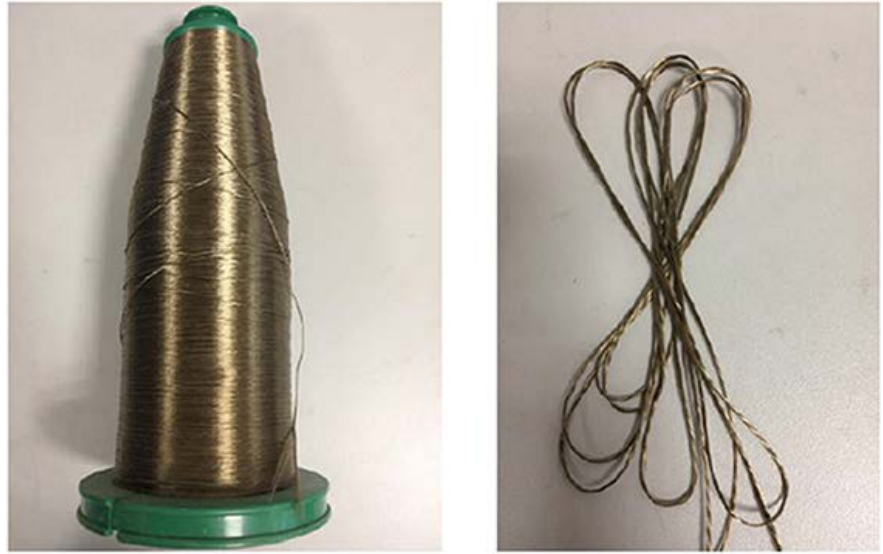
Figure 1. Basalt fiber filament tows.